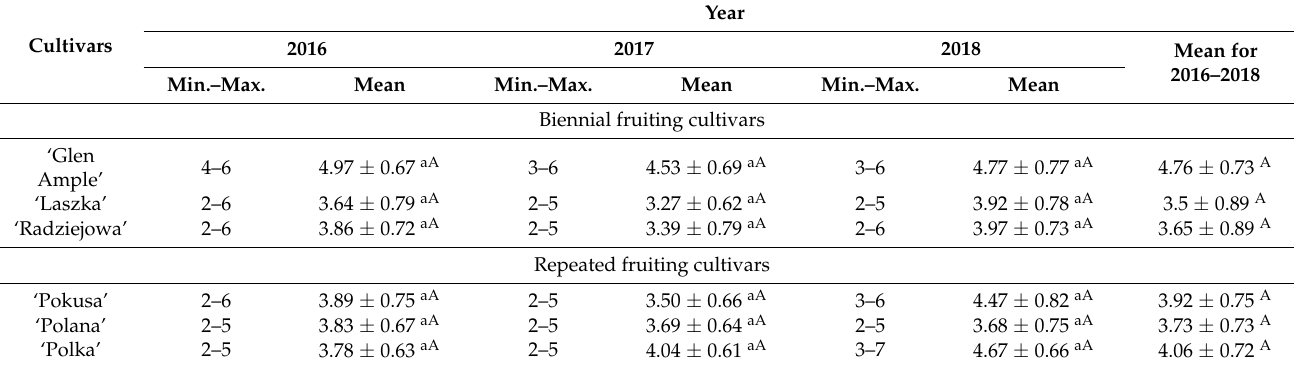
Table 2. Length of stamens per flower in six R. idaeus cultivars